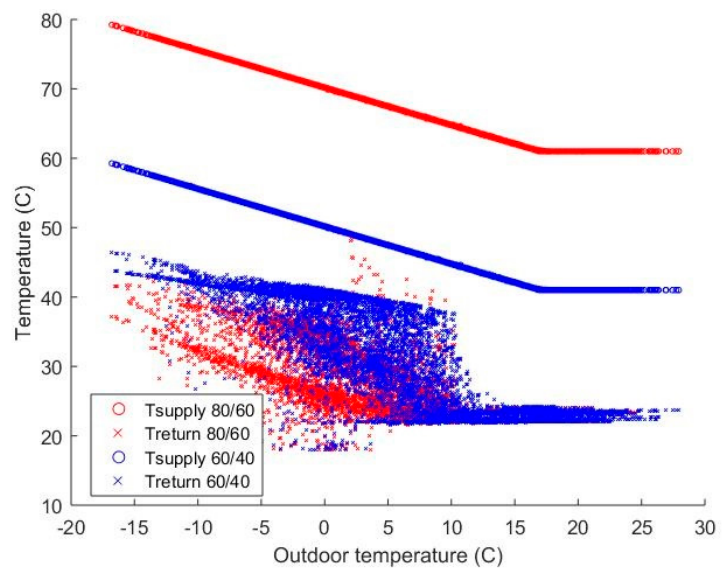
Figure 5. Radiator supply and return temperatures relative to outdoor temperature for AB_03 intermediate renovated.